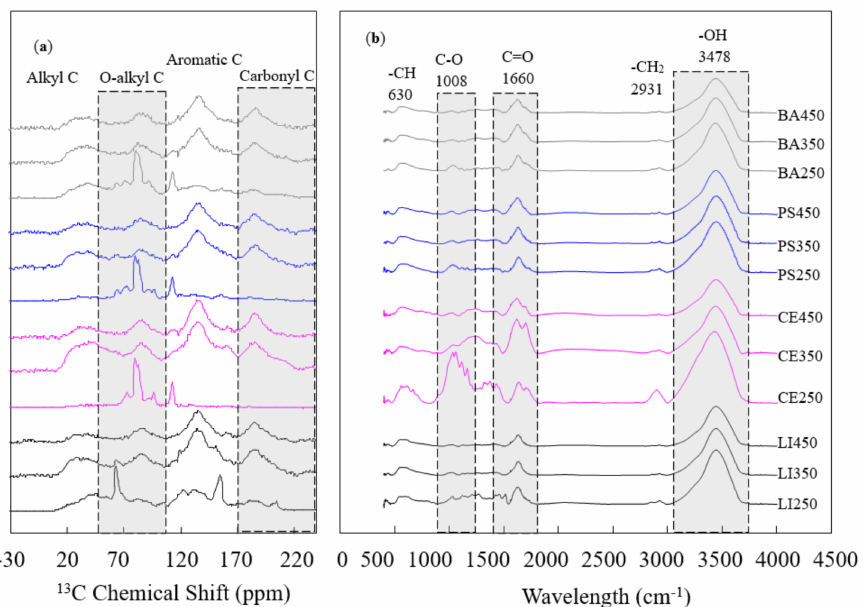
Figure 2. 13 C NMR ( a ) and FTIR ( b ) spectra of biochars from lignocellulose pyrolysis at different temperatures. The grey, blue, pink, and black line represented the BA-, PS-, CE-, and LI-derived biochars,